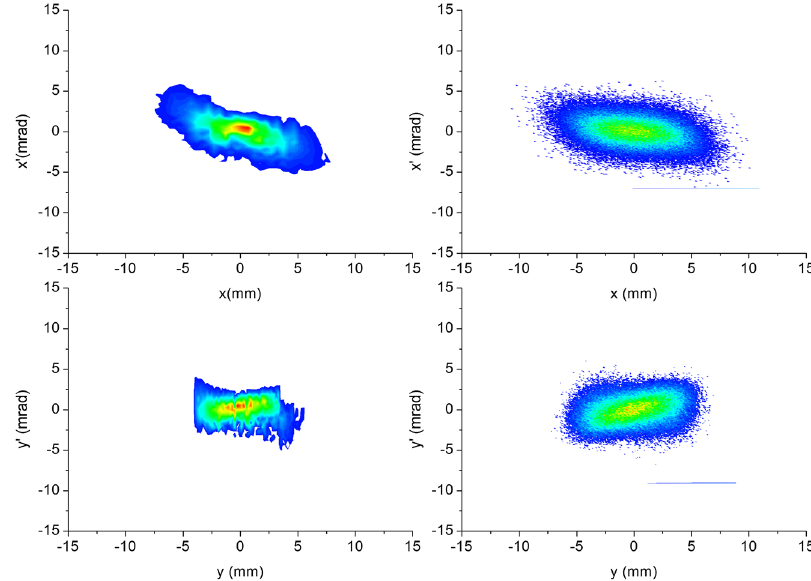
FIG. 14. Emittance simulation and measurements at the MEBT.